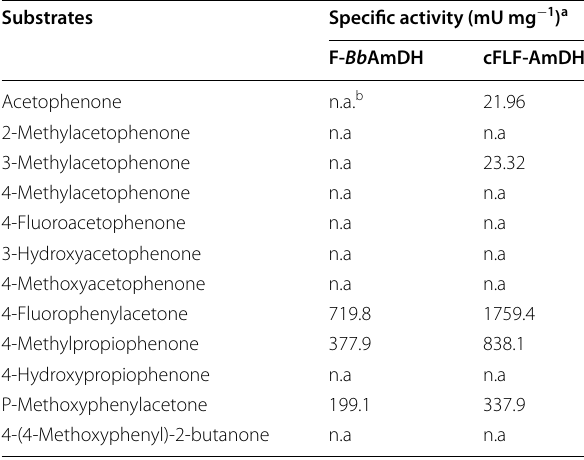
Table 4 Specific activity (mU mg − 1 ) of F- Bb AmDH and cFLF- AmDH toward aromatic ketones